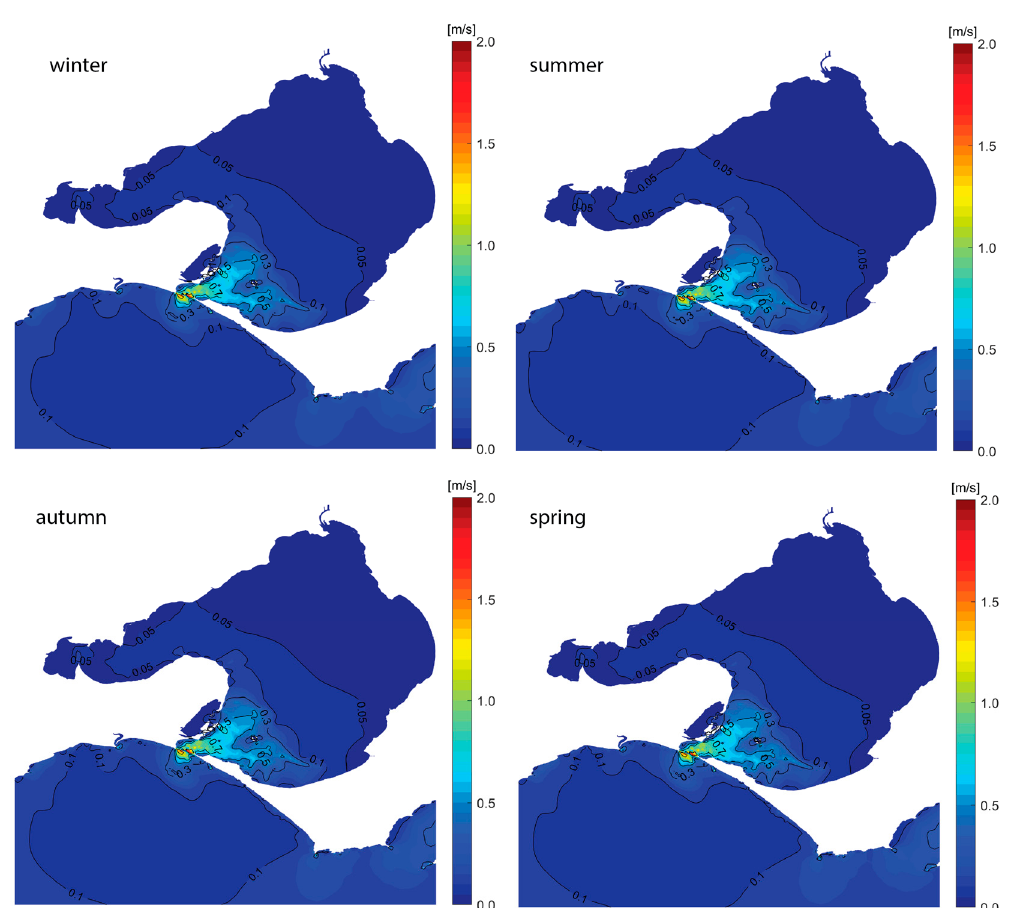
Figure 14. Seasonal variations in the mean current velocity. The mean magnitude can reach 2 m/s in the vicinity of PPH. After passing the southern region, the current speed is very weak.